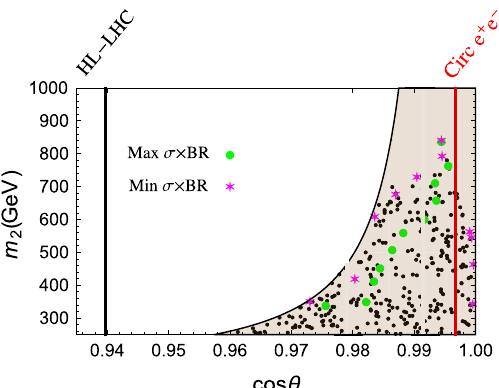
Fig. 11.3 First order EWPT-viable parameter choices for the singlet extended Standard Model. Allowed region (brown) is bounded by constraints from EW precision tests. Horizontal and vertical axes give cosine of the doublet-singlet mixing angle and singlet-like scalar mass, respectively. Vertical lines give prospective sensitivities of the HL-LHC and the FCC-ee (“Circ e + e − ”). Adapted from Ref [314]